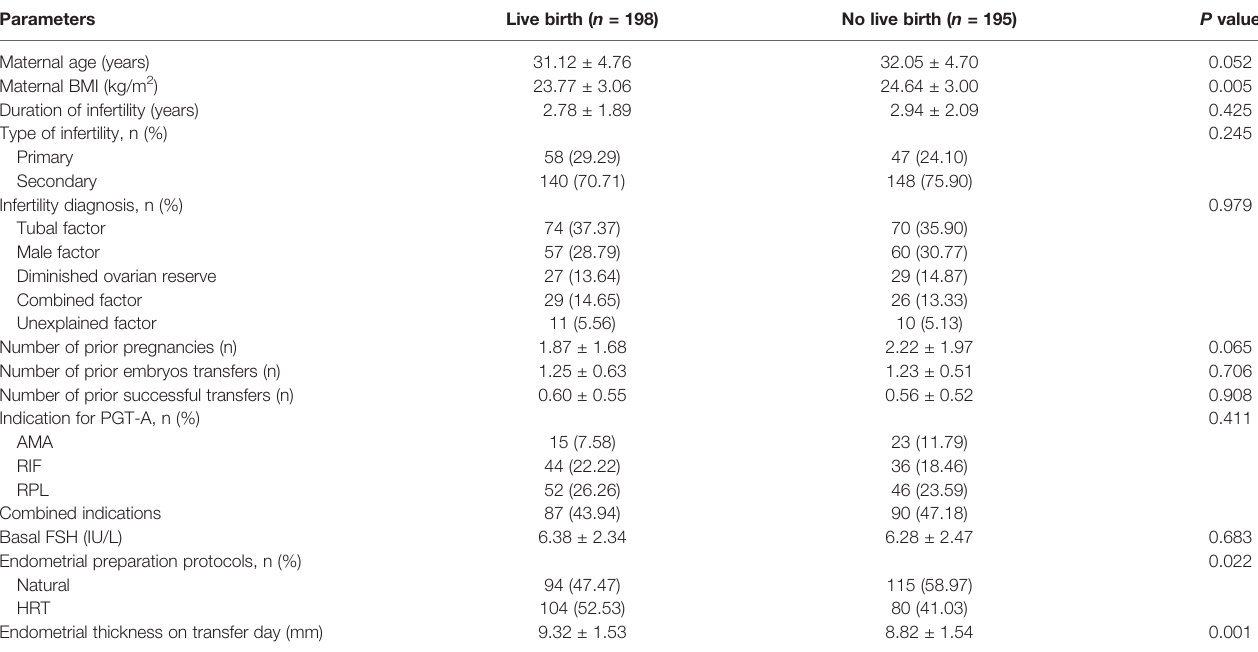
TABLE 2 | Patient characteristics of transferred frozen-thawed euploid blastocysts in terms of birth outcome. Parameters Live birth ( n = 198) Maternal age (years)